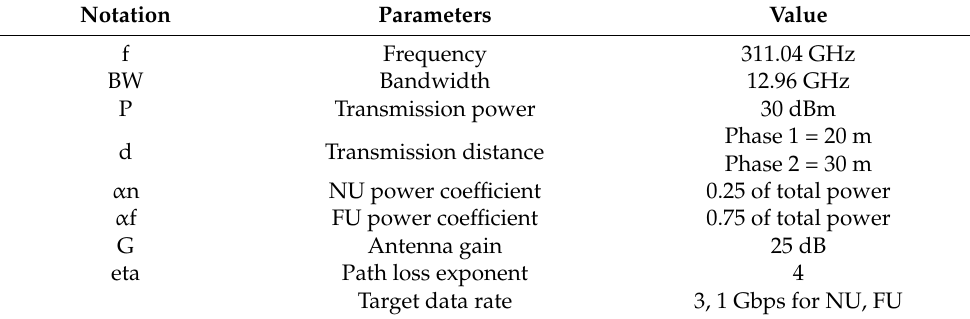
Table 1. Simulation parameters.